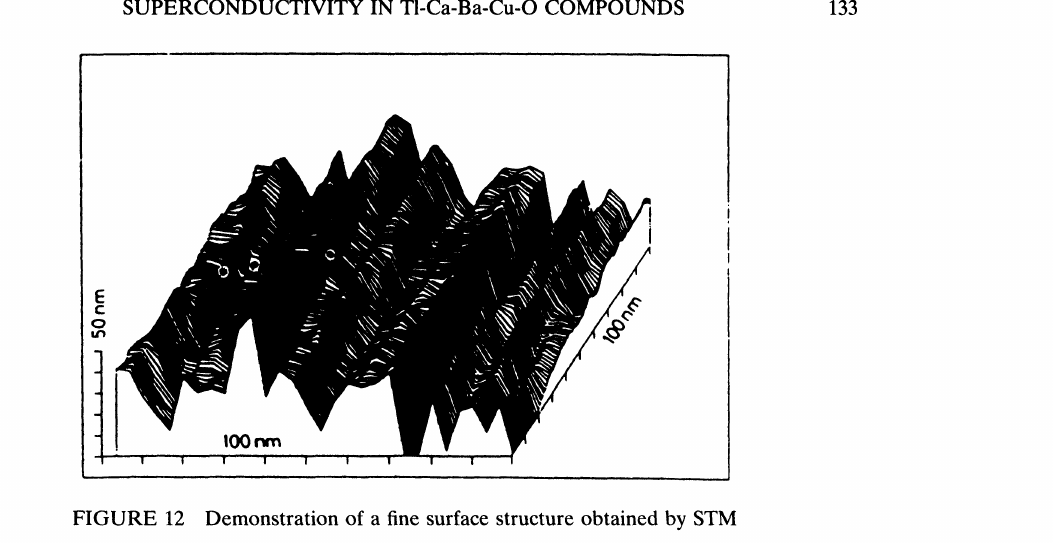
FIGURE 12 Demonstration of a fine surface structure obtained by